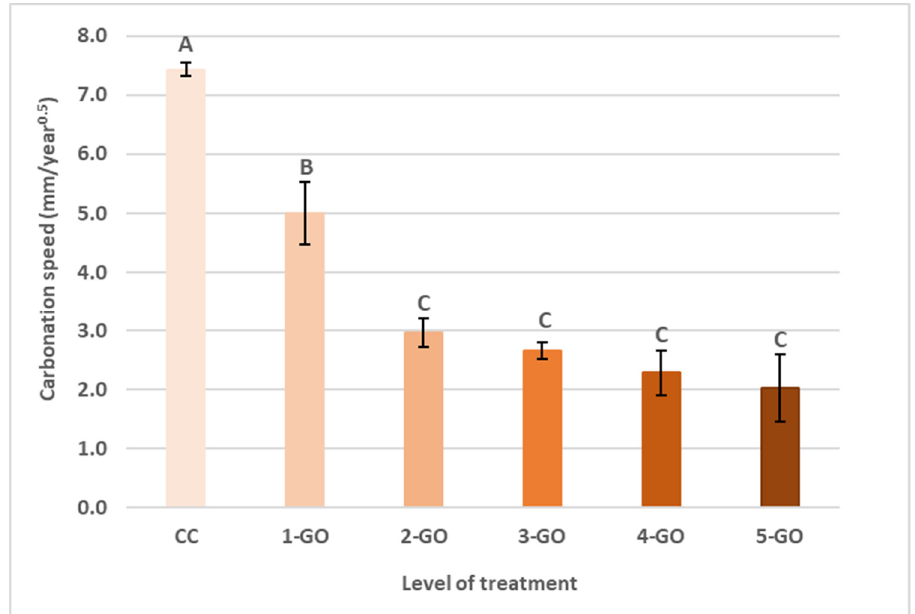
Figure 5. Carbonation speed at different treatment levels after 6 months exposure. Capital letters indicate minimum significant differences between treatment levels. Vertical bars represent mean and standard error (SE). Statistical differences are indicated by different letters (LSD test, p < 0.05).